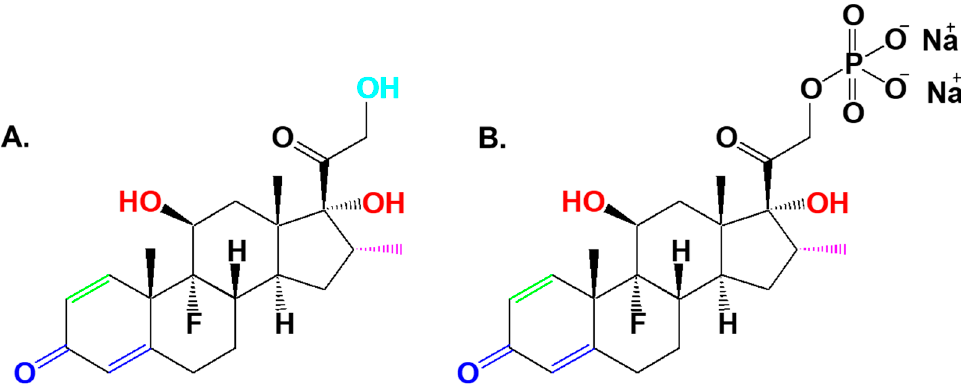
Figure 1. Chemical structure of dexamethasone ( A ) and dexamethasone sodium phosphate ( B ). Essential structures for pharmacological activity are highlighted in red (anti-inflammatory), in green (carbohydrate regulation), in blue (adrenocorticosteroid function), in light blue (Na + retention), and in violet (Na + elimination) [22,23].